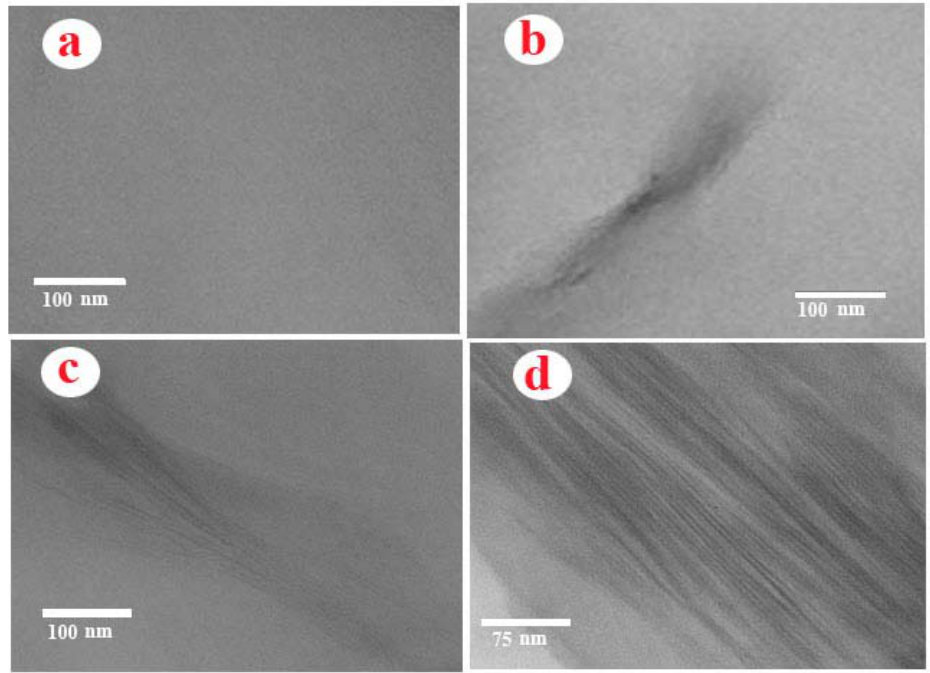
Fig. 5. TEM micrographs of (a) Pure SPBI, (b) SPBI/clay (1%)and (c) SPBI/clay (3%) and (d) SPBI/clay (5%) nanocomposite membranes at a magnification of 100 nm